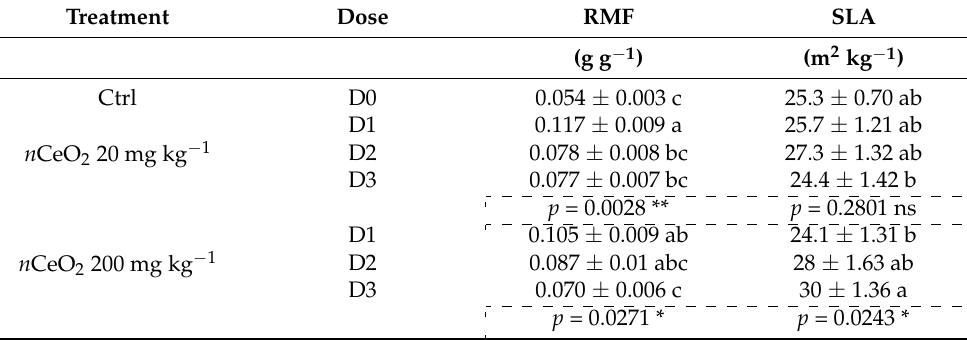
Root mass fraction (RMF), shoot to root ratio (S/R ratio), and specific leaf area (SLA) ± standard deviation of S. flos-cuculi grown in presence of different inputs of 20–200 mg kg − 1 n CeO 2 . Statistically significant differences ( p ≤ 0.05) are indicated by the letters using one-way ANOVA followed by Tukey’s test. Dashed box indicate ANOVA p -values ( p ≤ 0.05) within the n CeO 2 concentration. ns: not significant at p ≤ 0.05; * and ** significant at p ≤ 0.05 and p ≤ 0.01. Treatment